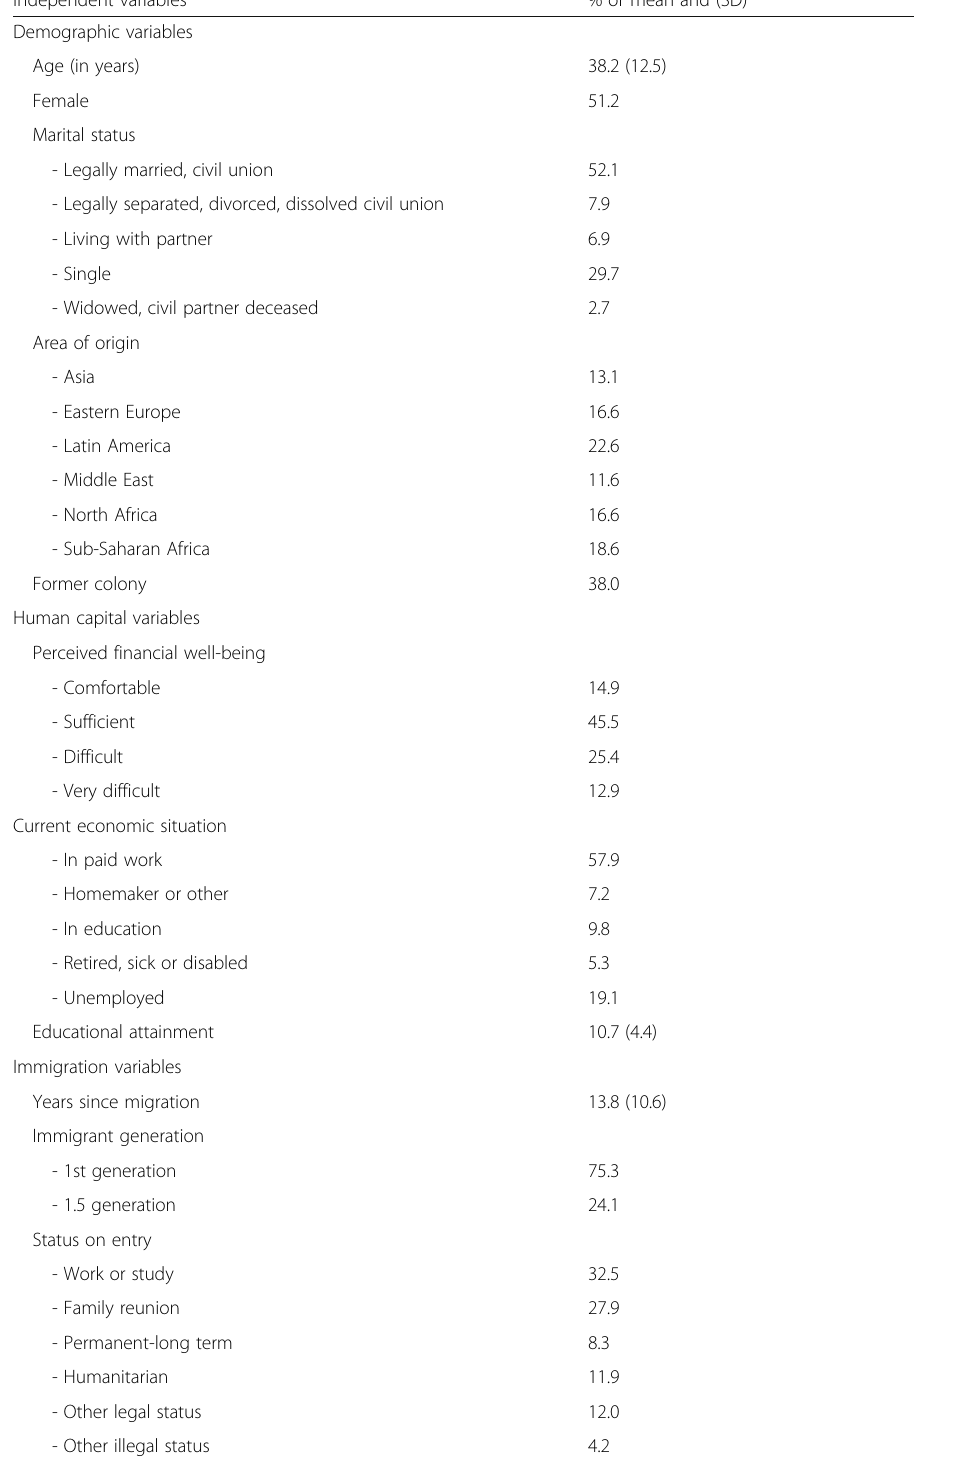
Table 3 Descriptive statistics on independent individual-level variables. Sample of immigrants ( N = 6255) in six selected countries of residence, between 2011 and 2012 Independent